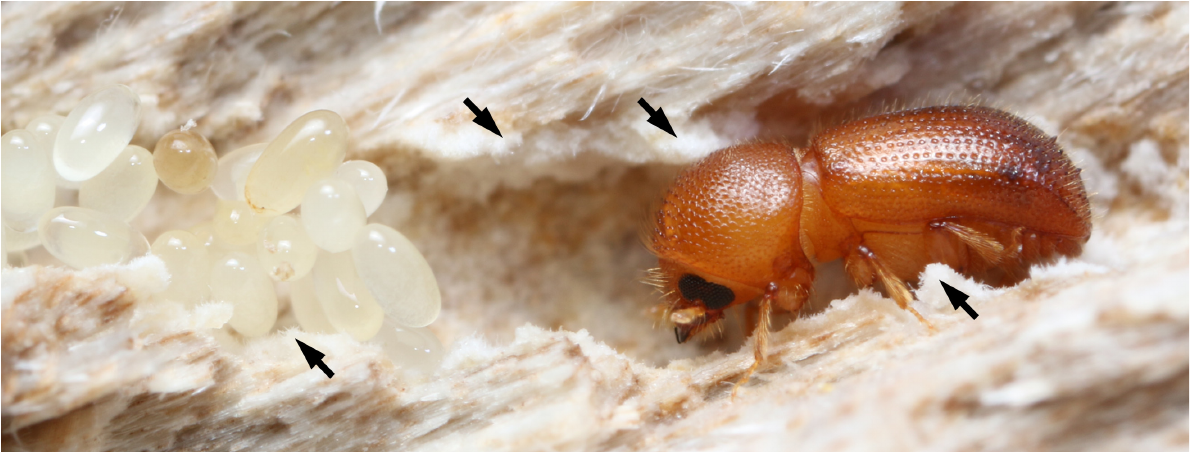
Fig 1. Female Ambrosiodmus lecontei with eggs in plant host. Note white fungal mycelial garden (arrows) in